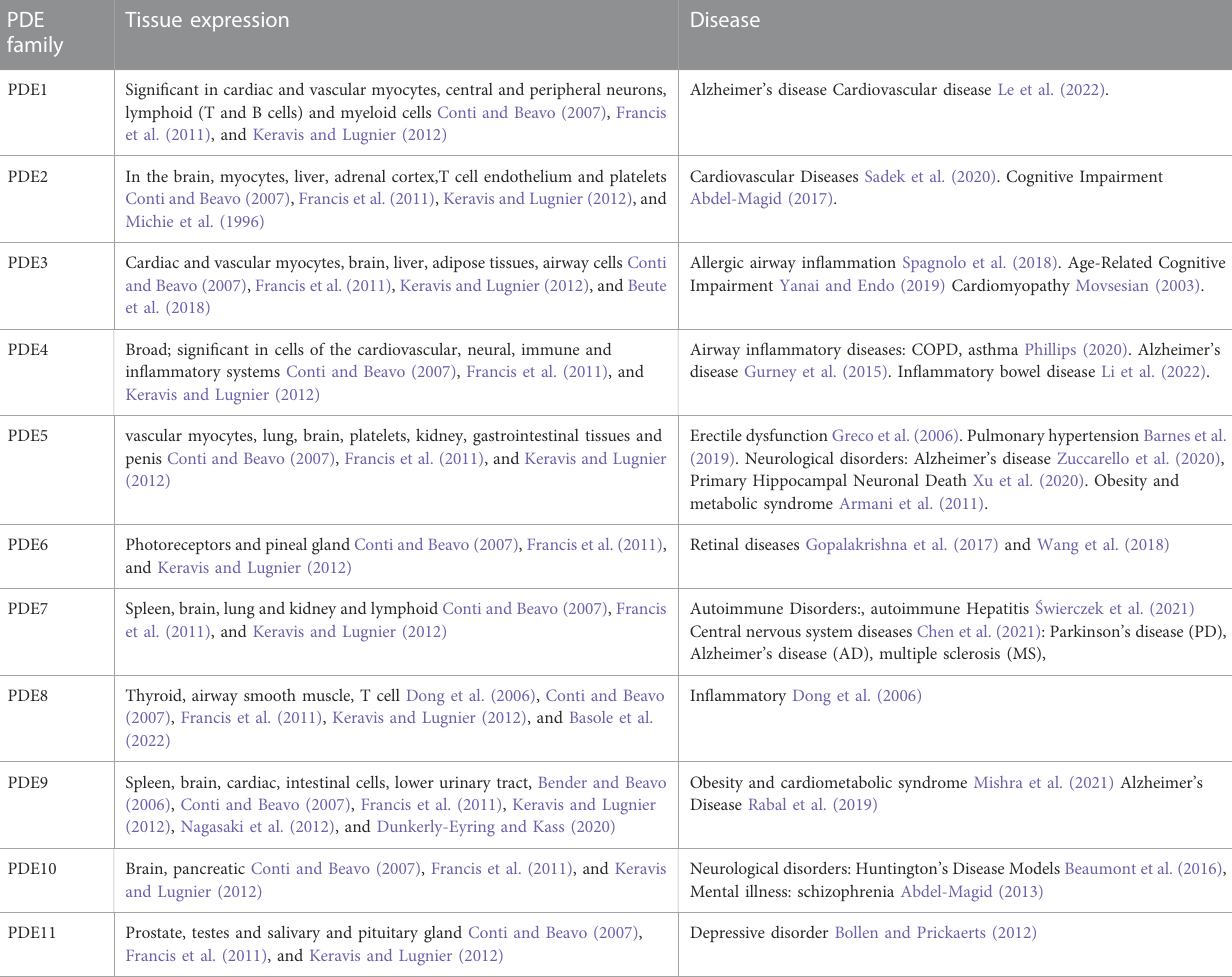
TABLE 1 PDE family and Tissue expression. PDE Tissue expression family